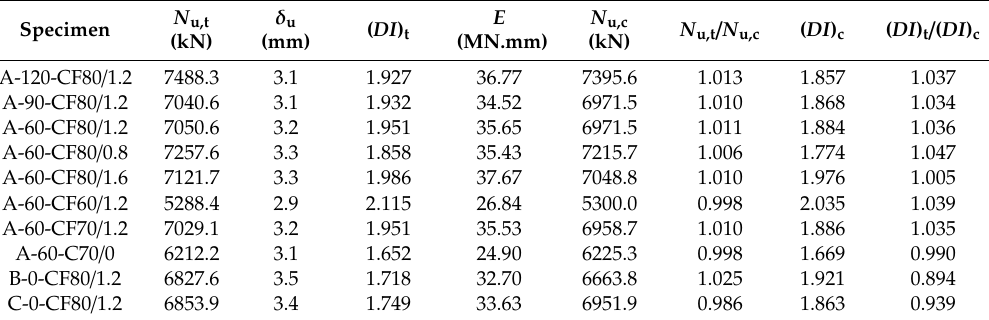
Table 3. Main test results of 10